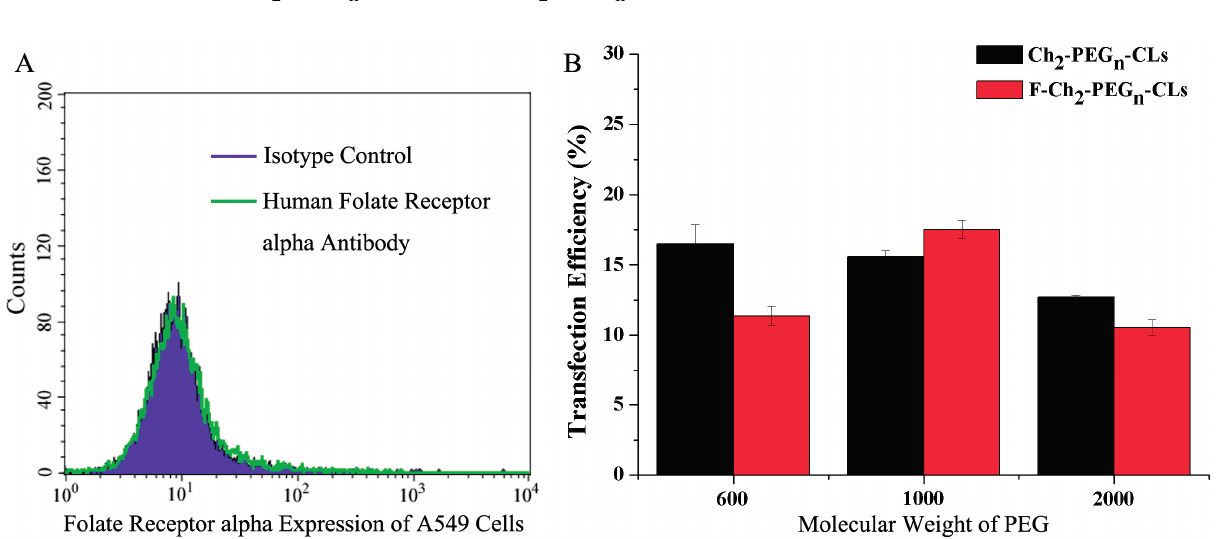
Figure 6. Folate receptor alpha expression and transfection efficiency on A549 cells. ( A ) Folate receptor alpha expression on A549 cells by flow cytometry and ( B ) The transfection efficiencies of Ch 2 -PEG n -CLs and F-Ch 2 -PEG n -CLs on A549